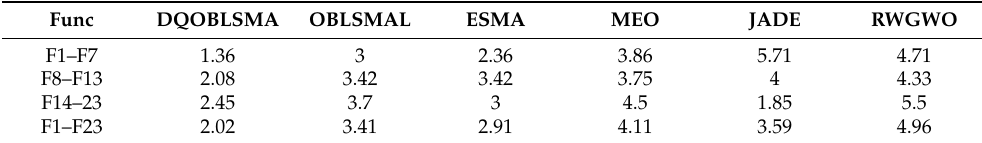
Table 10. Test statistical results of the Friedman test.